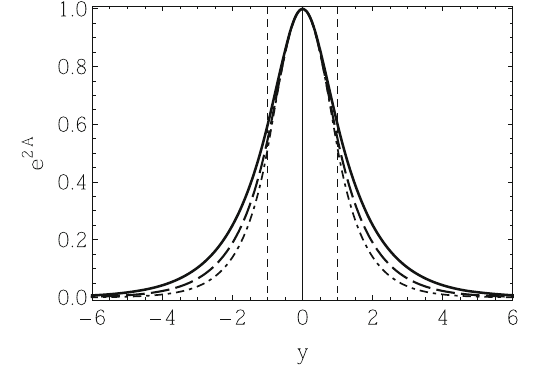
Fig. 7 Warp factor e 2 A ( y ) plotted for same values of n used in Fig. 6